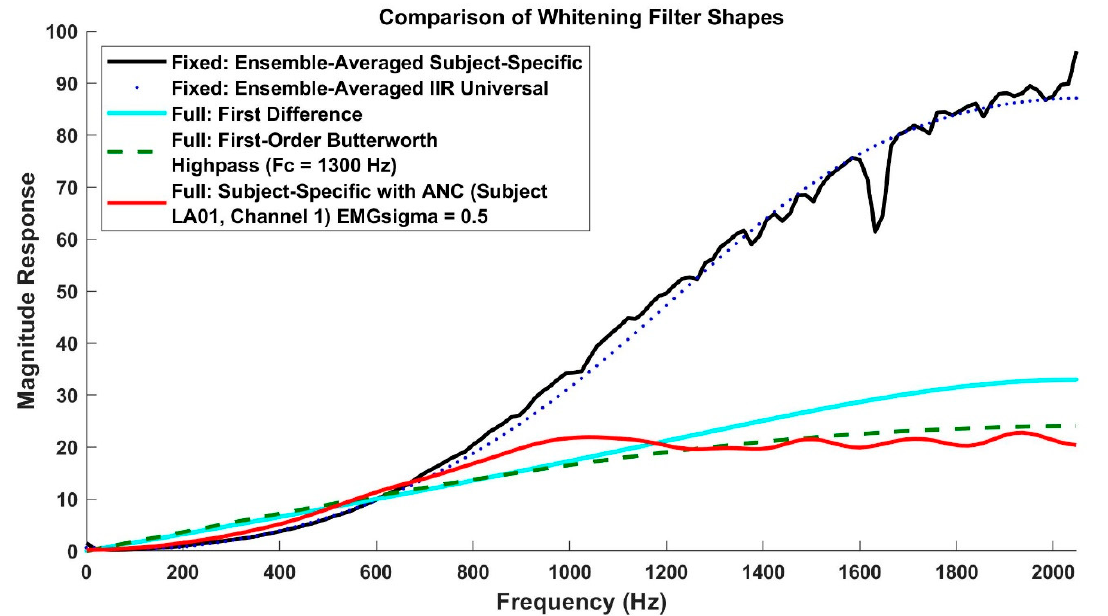
Figure 2. Comparison of whitening filter shapes for filters with a sampling rate of 4096 Hz. The gain of first difference and high-pass filters were manually matched over the frequency range up to ~1000 Hz, the region containing most EMG power. The graph based on ensemble filter shapes only shows the fixed Stage 1 filter for the subject-specific method and, separately, the Universal IIR method. ANC = adaptive noise canceling.